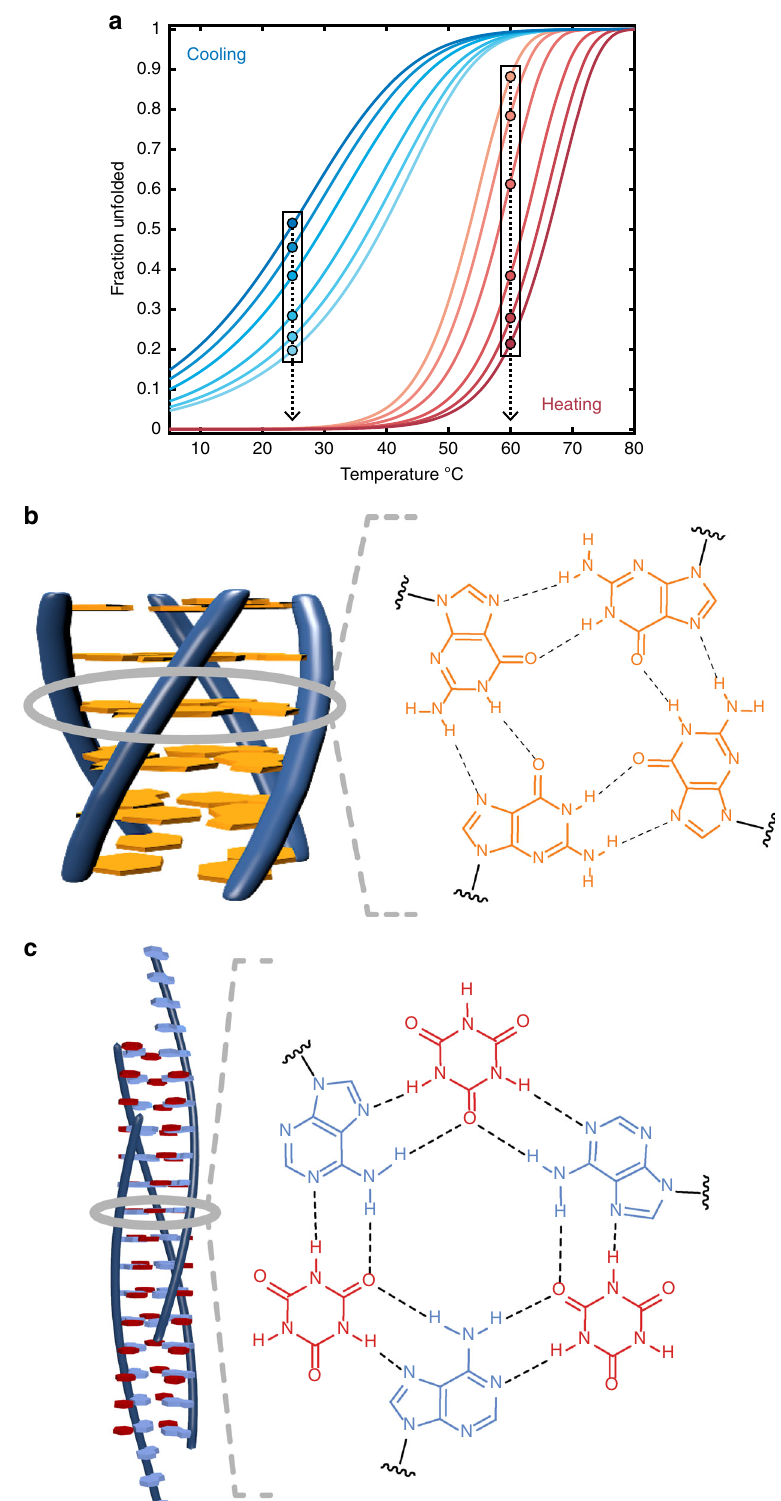
Fig. 1 Supramolecular assemblies and model-free analysis of multi-scan rate TH datasets. a A multi-scan rate TH dataset for generating a 3D supramolecular assembly map. The dashed arrows indicate temperature slices at which monomer concentrations and reaction rates are calculated at each temperature scan rate (colored circles in the black boxes). Light to dark blue and orange to dark red indicate slow to fast scan rates, respectively. b Tetrameric GQ structure formed by TG 4 T. The tetramolecular structure (left) contains stacked, Hoogsteen-hydrogen bonded G-tetrads (right). c Fiber structure formed by co-assembly of CA and poly(A) strands (left). CA brings about the growth of nano fi bers from poly(A) strands by participating in hexameric rosette arrays with adenine residues